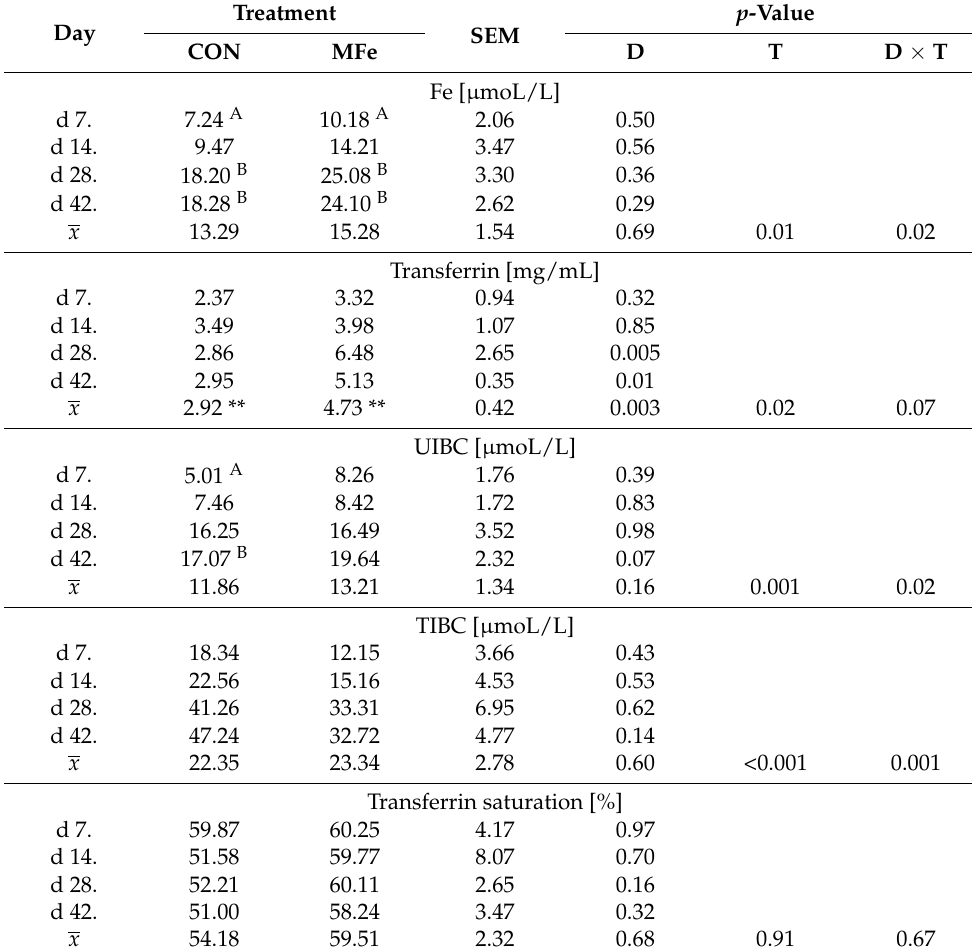
Table 4. Mean values of iron management parameters in the calves’ blood. Day